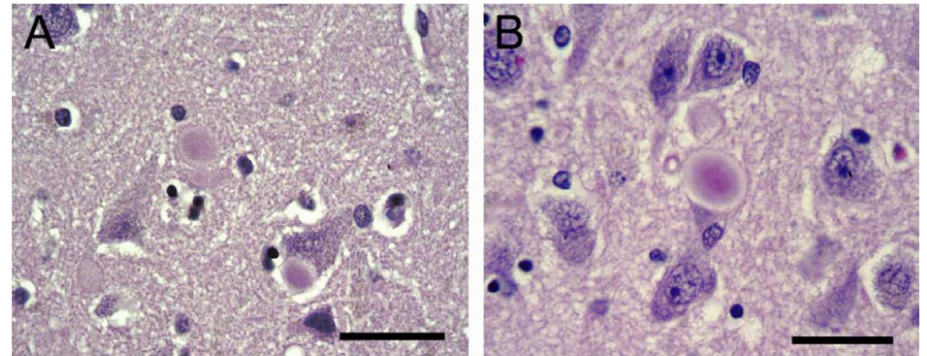
Figure 2. Intraneuronal inclusions similar to brainstem-type Lewy bodies identified in hippocam- pal neurons in regions CA2 ( A ) and CA3 ( B ) in a patient with both GD and parkinsonism H&E, 400 × magnification. Scale bars ( A ) 35 µ m; ( B ) 38 µ m. Reprinted with permission from Wong et al., 2004, Elsevier Inc.